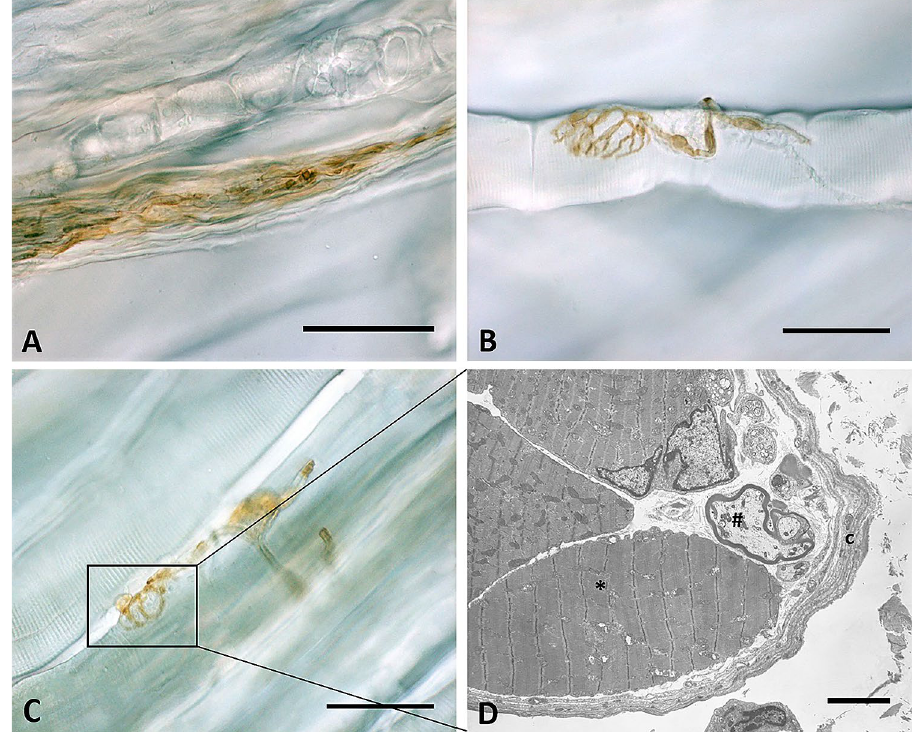
Figure 8. S100-positive corpuscles in gluteal fascia: Golgi tendon organ ( A ), neuromuscular junction ( B ) and muscle spindles ( C ) in gluteal fascia. In ( D ) is shown the TEM analysis of the muscle spindle: a connective tissue capsule (c) wraps a small group of muscle fibers (*) and nerve fibers (#). Scale bars: 50 µm ( A , B , C ), 5 µm ( D ).